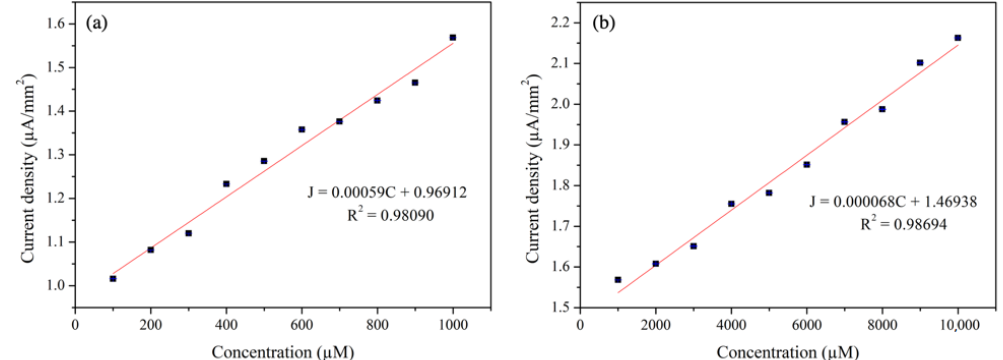
Figure 8. Current density–analyte concentration calibration curves for the BaTiO 3 /MWCNT compos- ite (2:1)-based electrode in ( a ) 100–1000 µ M and ( b ) 1000–10,000 µ M citric acid measured at a scan rate of 100 mV/s for the reduction reaction at − 0.67 V.